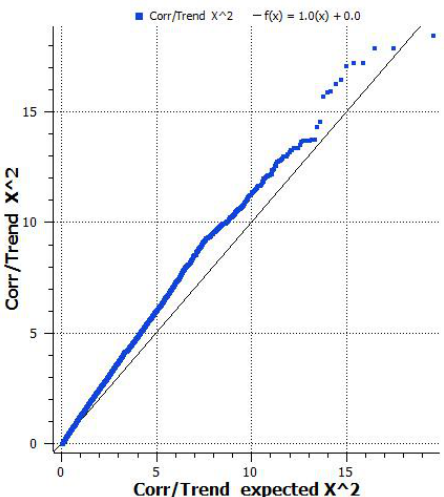
Figure 2. ( A ) Manhattan plot and ( B ) QQ plot of P -values of the SNP-based association meta-analysis against the intramuscular fat content percentage (IMF %) in pigs. The red line indicates the threshold for genome-wide significance ( P < 4.5 × 10 − 8 ) for 68,529 SNPs adjusted for sex and a minor allele frequency (MAF) of <0.01. The QQ plot shows that the samples where normally distributed according to their IMF % value relative to the SNPs scored in their genotype.